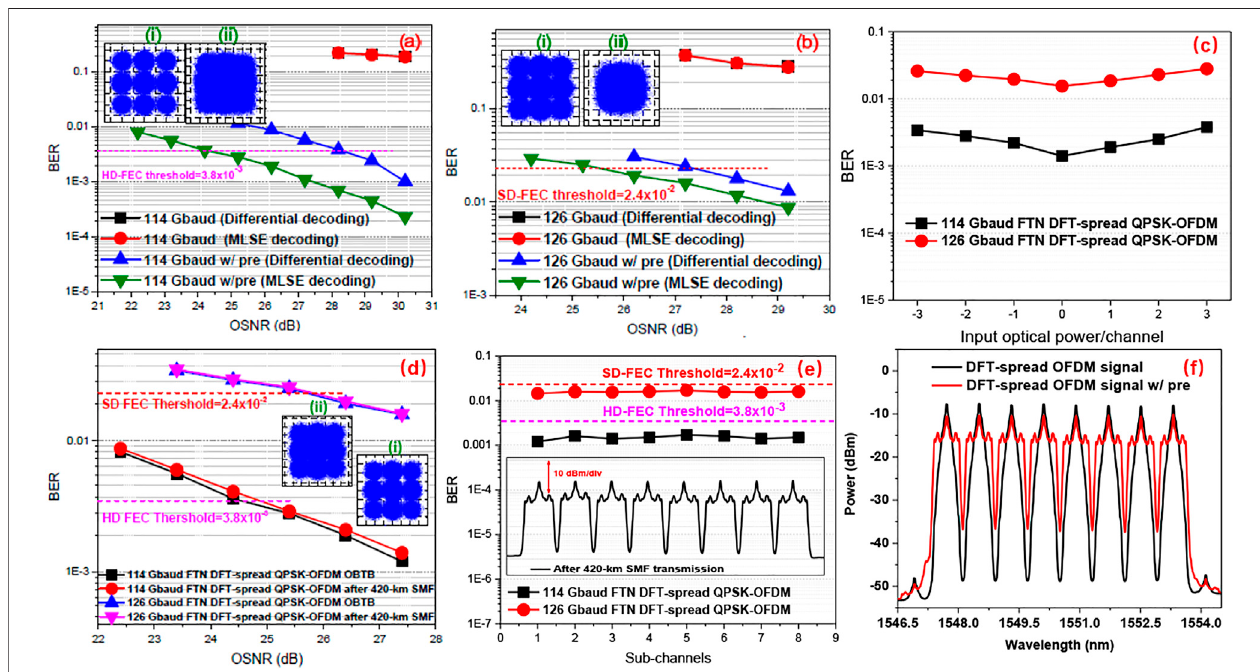
FIGURE4|(A) BERversusOSNRof114 GbaudFTN-DFT-spreadQPSK-OFDMafter420-km fi bertransmission, (B) BERversusOSNRof126 GbaudFTN-DFT- spread QPSK-OFDM after 420-km fi ber transmission, (C) BER versus input power per channel of the 3 rd sub-channel of WDM after 420-km transmission, (D) BER versus OSNR of the 3 rd sub-channel of WDM in OBTB and after 420-km fi ber transmission, (E) BERs versus all sub-channels of 114 and 126 Gbaud FTN-DFT-spread QPSK-OFDM after 420-km fi ber transmission, and (F) optical spectrum (0.02 nm) of WDM signal after 420-km fi ber